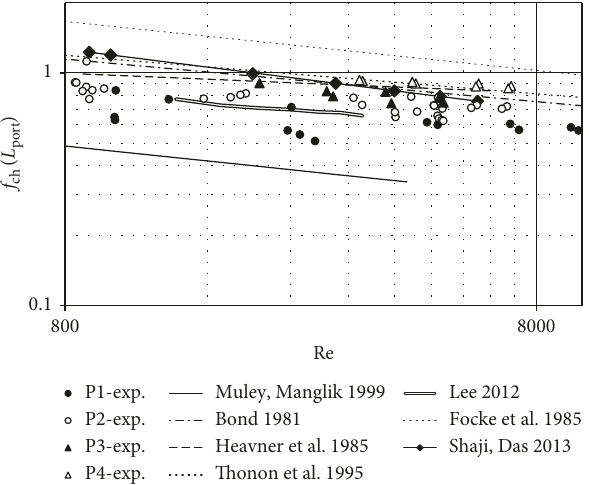
Figure 7: Fanning factor for plates P1–P4 with chevron pattern